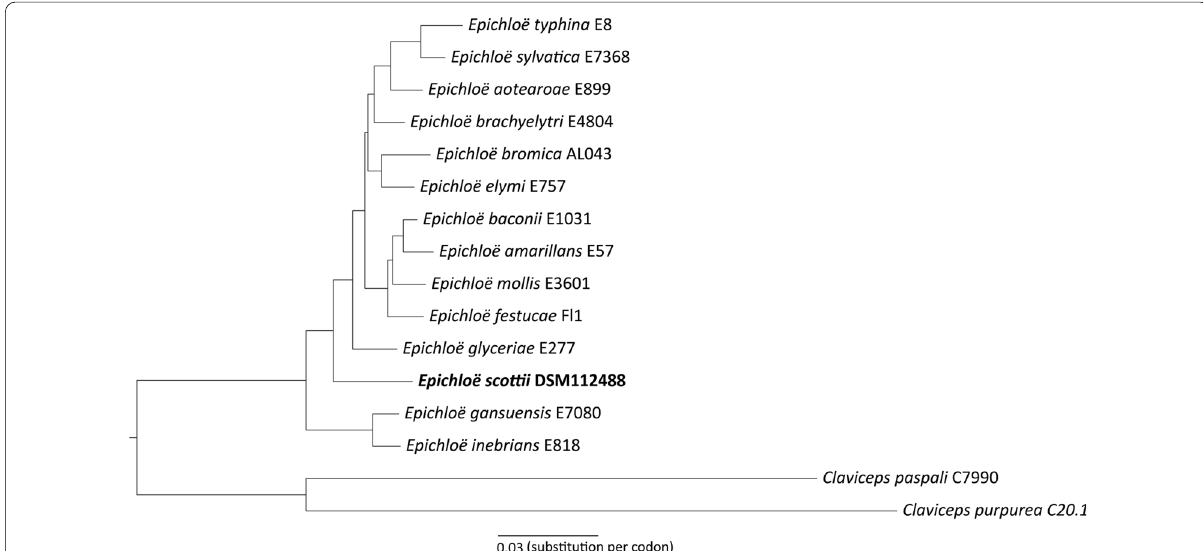
Fig. 5 Multi-gene phylogeny of haploid species of the genus Epichloë . A maximum likelihood phylogeny of all haploid species in the genus Epichloë with an available genome reference was built using 2,828 single copy protein orthologs and rooted on two species in the outgroup genus Claviceps . All branches have support values of 1